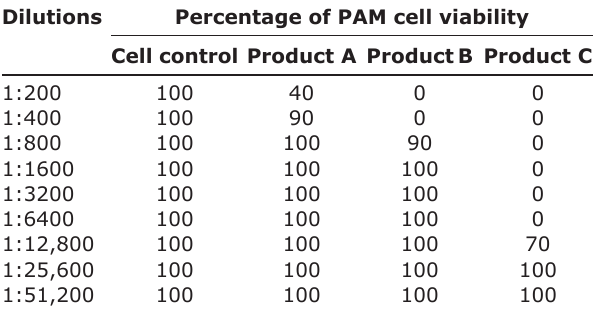
Table-1: The percentage of alive primary PAM cells after incubation with a certain disinfectant of various concentrations. Dilutions